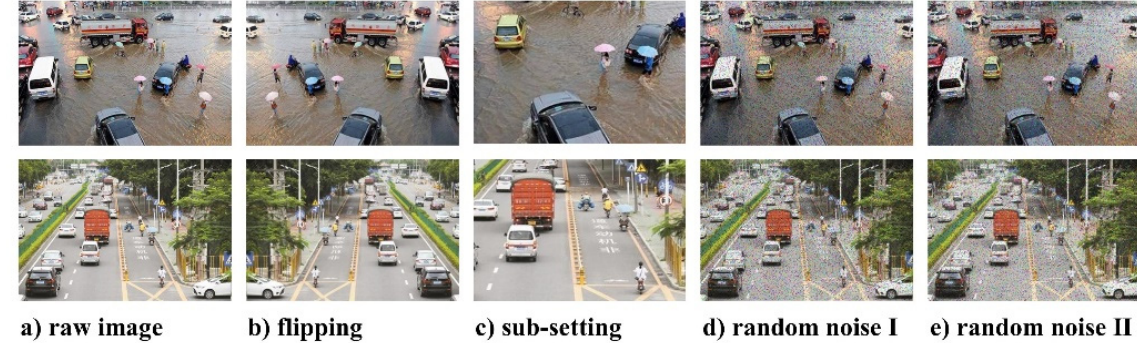
Figure 9. Data augmentation.